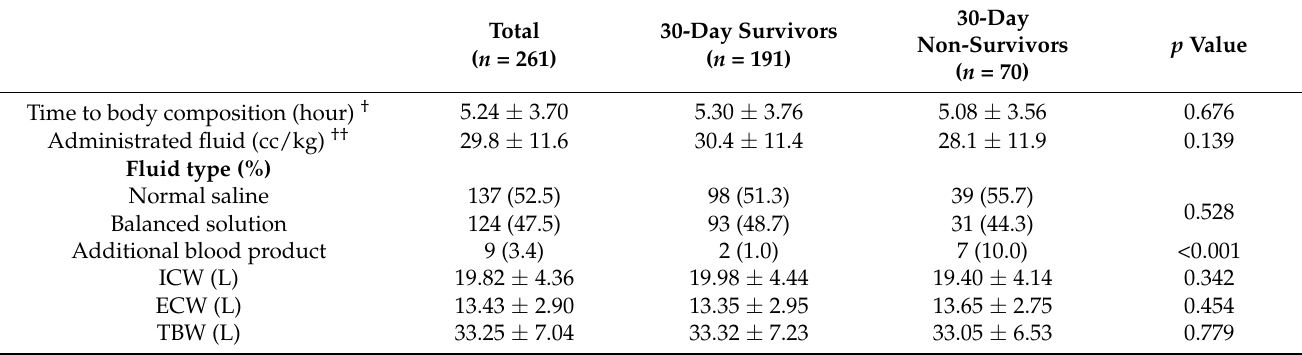
Table 2. Comparison of the body composition between the 30-day non-survivor group and the 30-day survivor